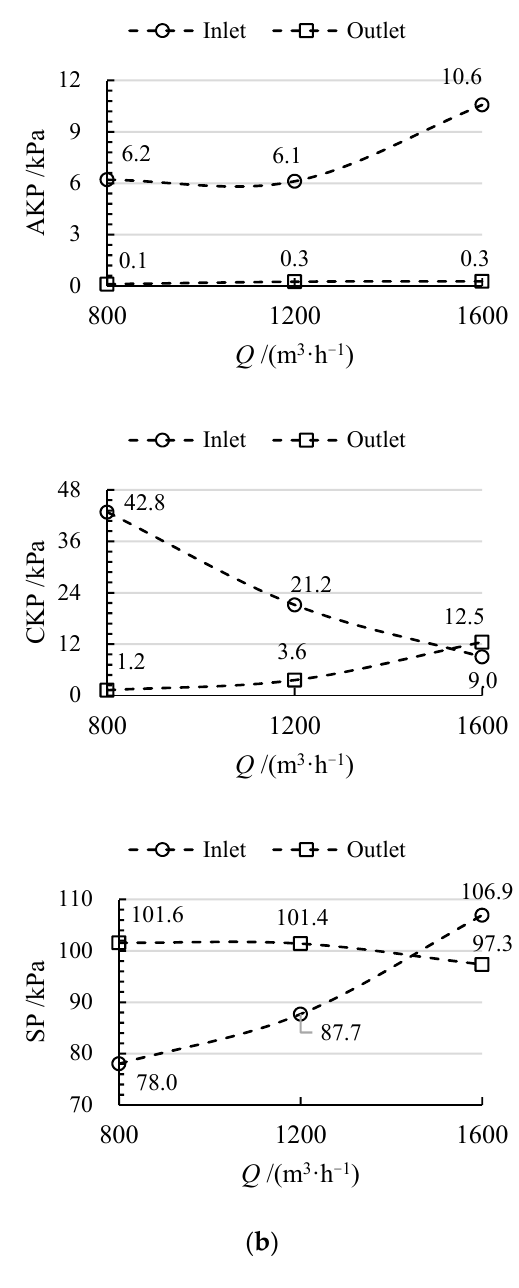
Figure 12. The distributions of kinetic pressure and static pressure on the inlet and outlet of the ( a ) guide vanes and ( b )